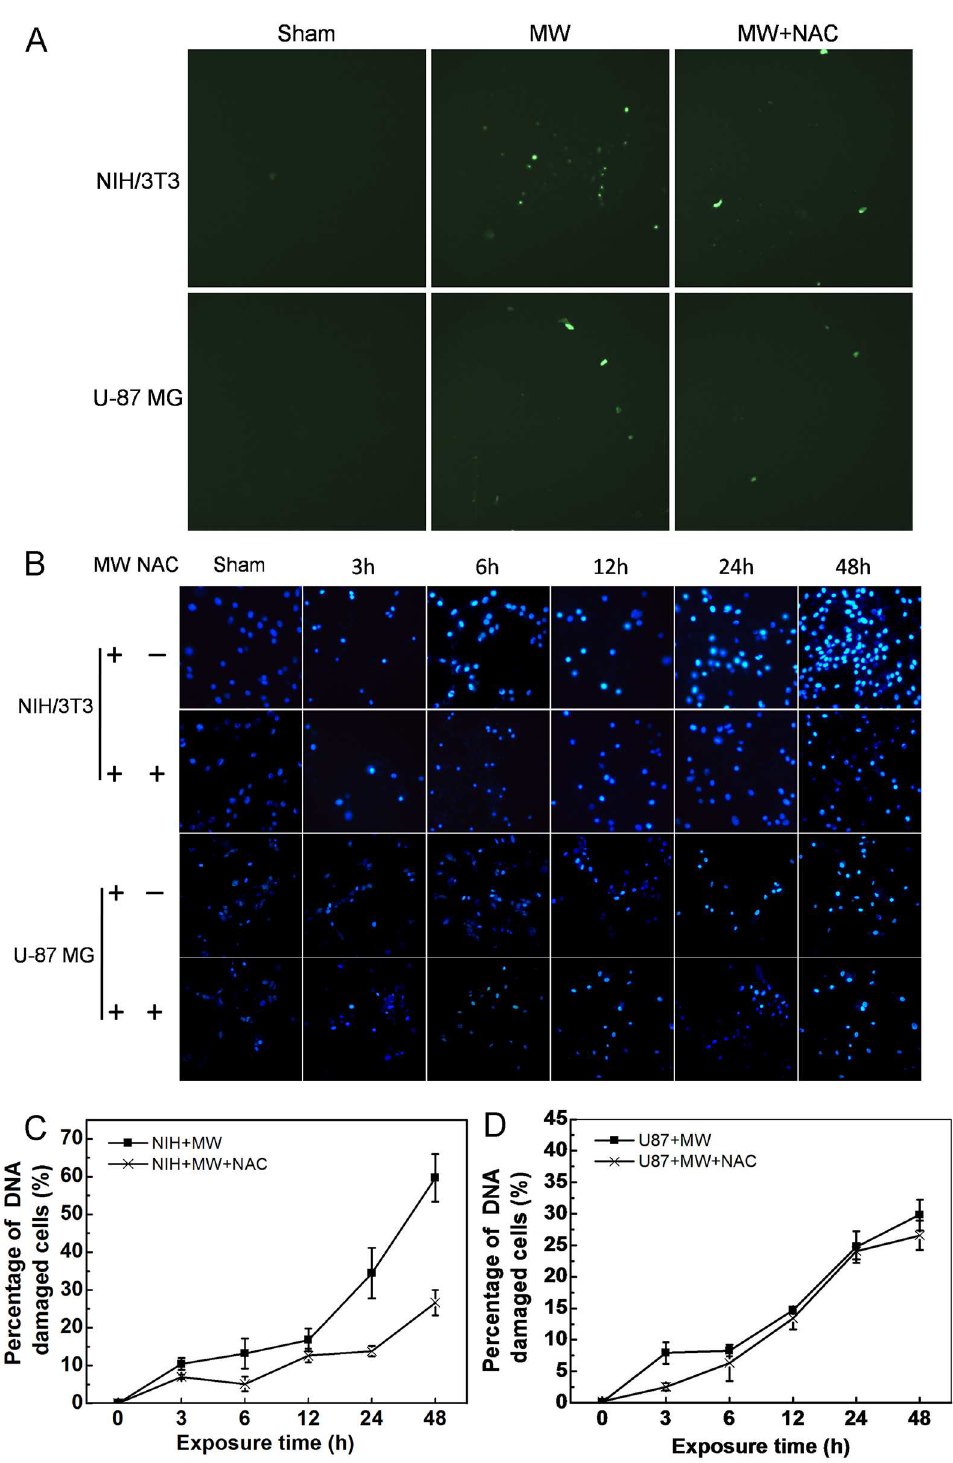
Fig 4. Exposure to 1800MHz microwave induces oxidative DNA damage in NIH/3T3 and U-87 MG cells. (A) In situ TUNEL detection of DNA fragmentation. (B) Hoechst 33258 staining assessment of nuclear condensation in NIH/3T3 and U-87 MG cells. Fluorescent images of DNA damaged cells were visualized under an Olympus fluorescent microscope (20 × ). (C, D) Quantitative analysisof DNA damages in NIH/3T3 and U87-MG cells stained by Hoechst 33258 shown in (B). MW, microwave; NAC, N-acetyl-L-cysteine.Data represent mean ± S.D. (n = 3; * P < 0.05 vs. sham group.)